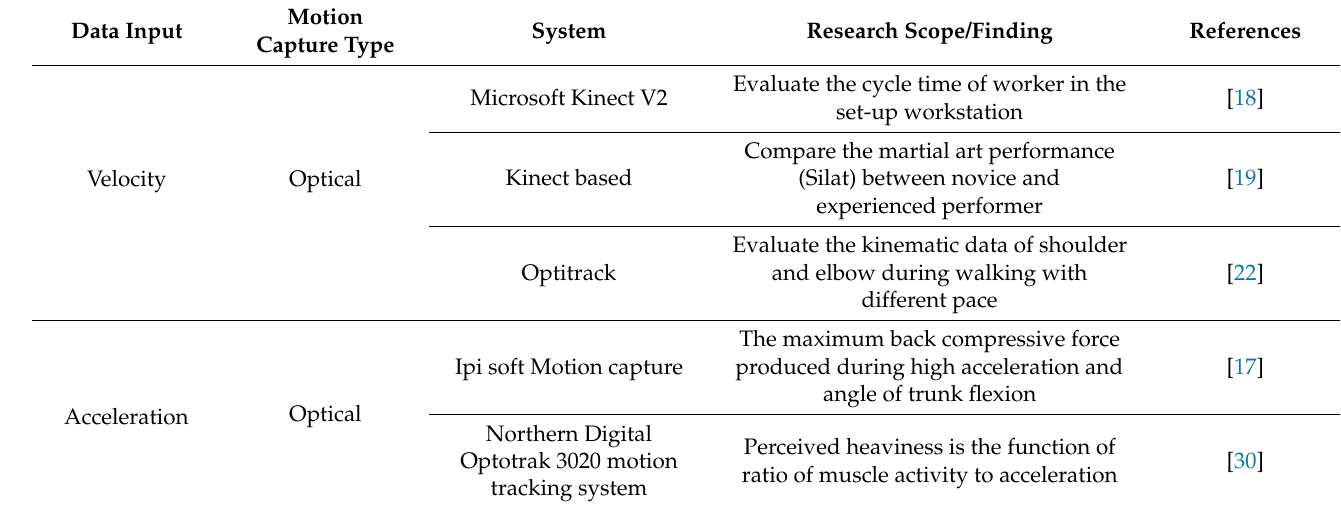
Table 3. Summary of recent studies related to kinetic and kinematic variables by using motion